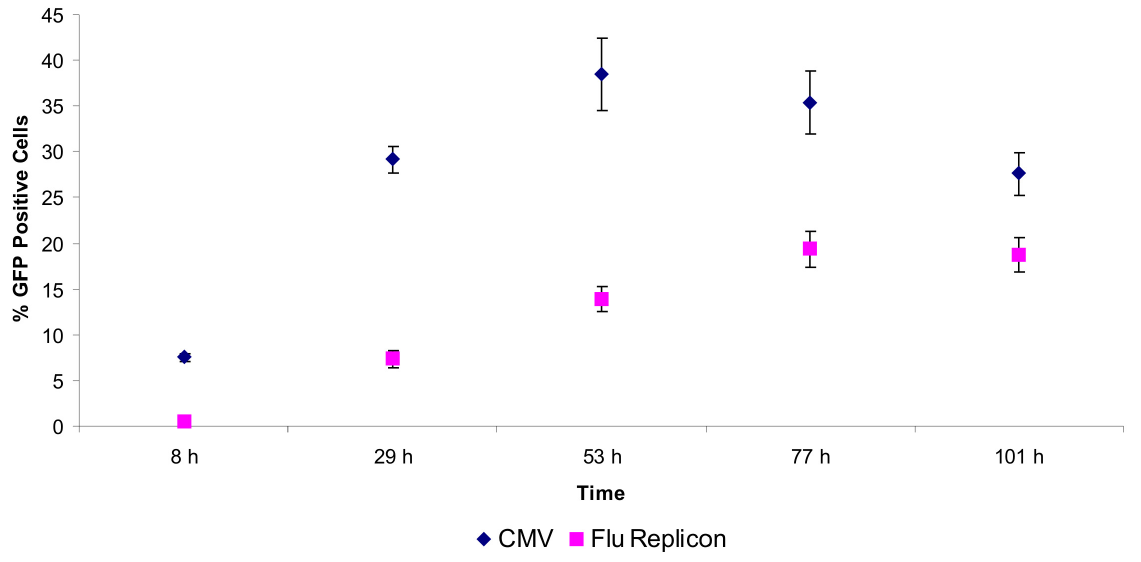
Figure 3. Transfection efficiency time course. HEK-293 cells either tranfected with pEGFP-N1 (CMV) or with the influenza replicon and pMono- EGFP (Flu Replicon) were monitored over a period of 101 hours by FACS analysis. Data represents arithmetic mean values and standard deviation.